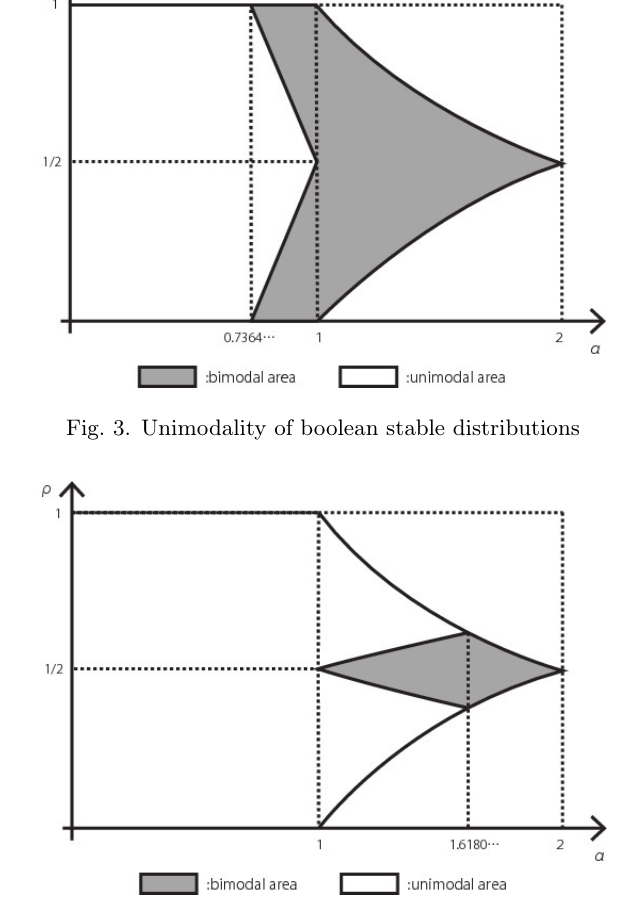
Fig. 4. Unimodality of monotone stable